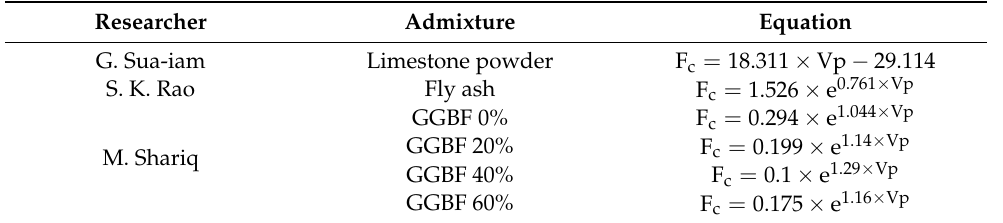
Figure 2. Previously proposed equations for estimating compressive strength by ultrasonic pulse velocity [26–29].